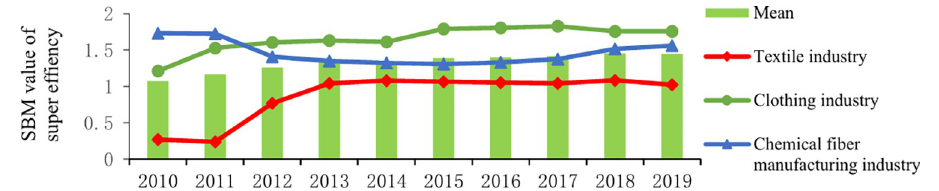
Fig 2. SBM value of super efficiency of textile and apparel industry from 2010 to